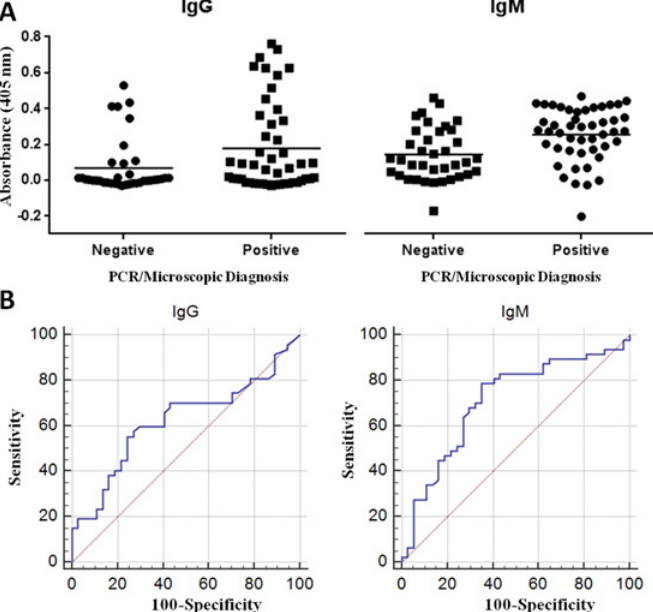
Fig 7. Calflagin-based serodiagnosis of trypanosome infections in Ugandan cattle. (A) ELISA signal intensities resulting from bovine IgG and IgM antibodies binding to solid-phase adsorbed recombiant T . congolense calflagin. All values were normalized against signals elicited from plasma of laboratory raised, trypanosome negative calves. (B) ROC curves generated from the serodiagnostic ELISA results. Areas under curve for IgG and IgM were 0.623 and 0.709 respectively. For reference, an area under the curve of 1.00 equates to a test with 100% sensitivity and specificity, whereas an area under the curve of 0.500 indicates that a test has no value in differentiating between the binary